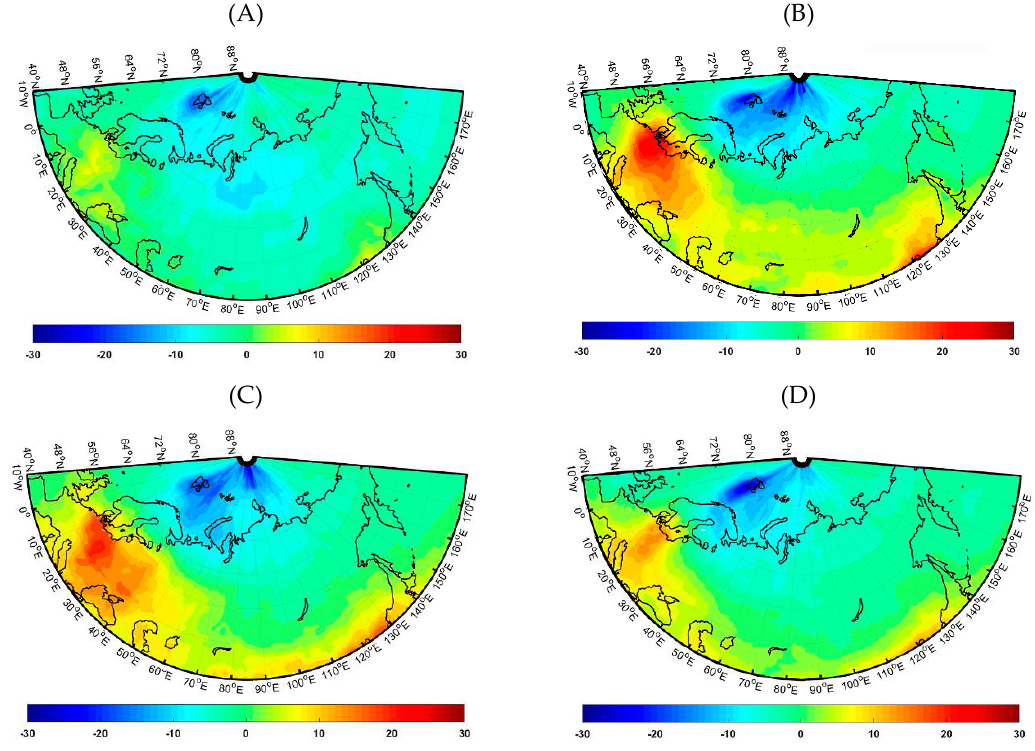
Figure 1. Relative difference (in %) between the new (Macv2) and the old (Macv1) aerosol correction factors, CF for the central months of the seasons: January ( A ), April ( B ), July ( C ), October ( D ).